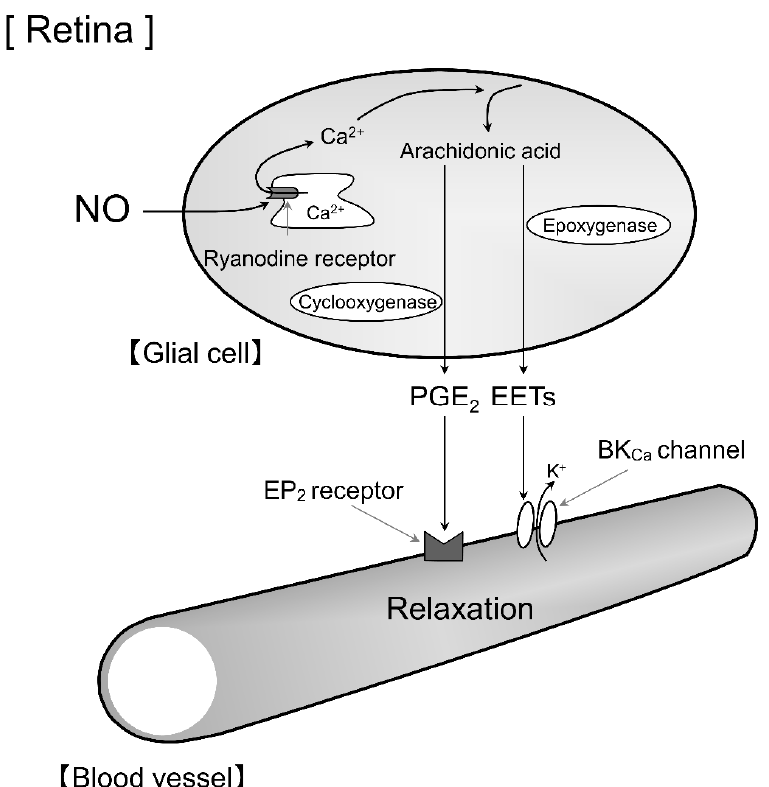
Figure 6. Schema of glial cell-mediated vasodilation mechanisms in the retina. Stimulation of NO on glial cells enhances ryanodine receptor-mediated Ca 2+ release and thereby stimulates production of prostaglandin E 2 (PGE 2 ) or epoxyeicosatrienoic acids (EETs) in the cells. The released PGE 2 and EETs dilate retinal blood vessels through stimulation of the prostanoid EP 2 (EP 2 ) receptor and large-conductance Ca 2+ -activated K + (BK Ca ) channels, respectively.